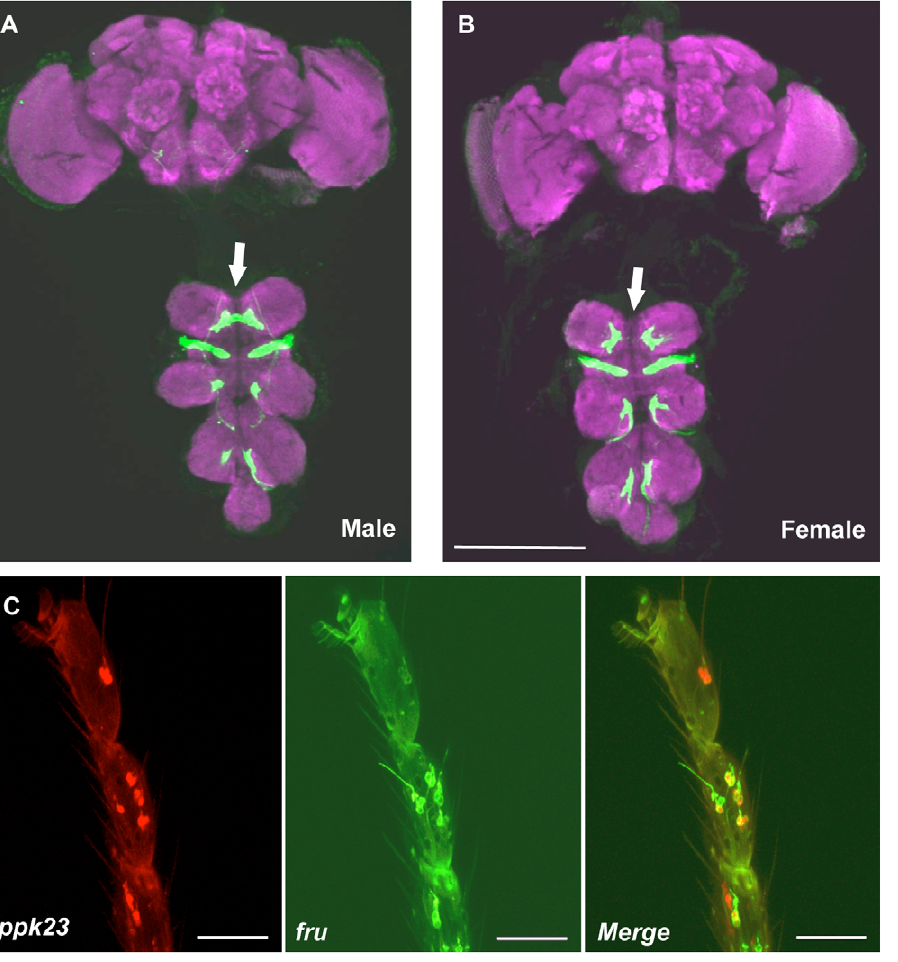
Figure 3. Axonal projections of ppk23 -expressing cells are sexually dimorphic. (A) and (B) The axonal projections of ppk23 -positive cells are sexually dimorphic. Left panel is a male (A) and right panel is a female (B). Panels represent brain (top) and thoracic ganglion (bottom) confocal z- stacks that were dissected from a single animal. Note the lack of midline crossings by foreleg ppk23 -positive axons in females (white arrows). Scale bars represent 100 m m. Identical dimorphic axonal projection patterns were observed in at least five individuals per sex. (C) ppk23 expression co- localizes with fru expression in the forelegs of males. Red marked ppk23 -expressing cells and green marked the fru positive cells. The majority of ppk23 -expressing cells also show fru expression. Scale bars represent 20 m m. Genotype imaged: w; ppk23-GAL4 . UAS-RFP/lexAop-rCD2::GFP; fruP1.LexA/ + .